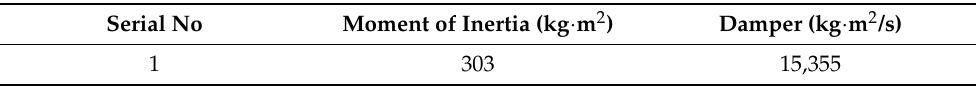
Table 1. Hydraulic link